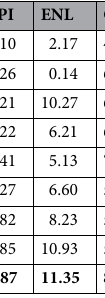
Table 3. Experiment results of our adaptive-SIN and other 8 algorithms evaluated based on the metrics of EPI, ENL and CNR for the patients dataset captured from Topcon OCT machine. The bold numbers mean the best result compared with other